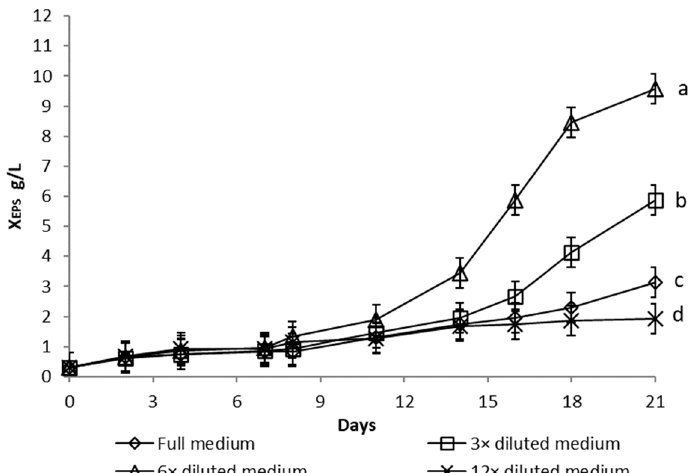
Figure 3. The dry weight of extracellular polysaccharides (X EPS ) produced during cultivation of Dictyosphaerium chlorelloides in full and nutrients limited media. Means with at least one letter the same are not significantly different ( p > 0.05). Comparison of statistical significance is presented for X EPS on the 21st day of cultivation. Error bars indicate the standard deviations. All experiments were carried out in three biological replicates.